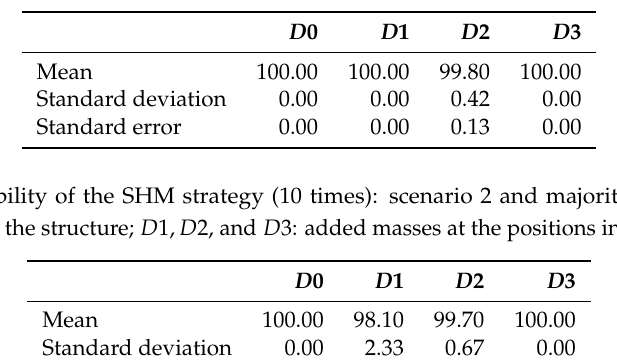
Table 10. Repeatability of the SHM strategy (10 times): scenario 1 and sum of the inverse distances approach. D 0: healthy state of the structure; D 1, D 2, and D 3: added masses at the positions indicated in Figure 4.